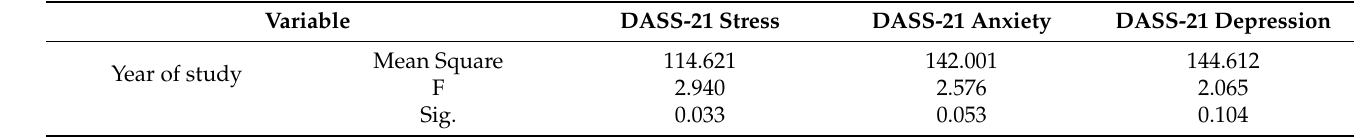
Table 4. One-way ANOVA of the DASS-21 scores with the year of